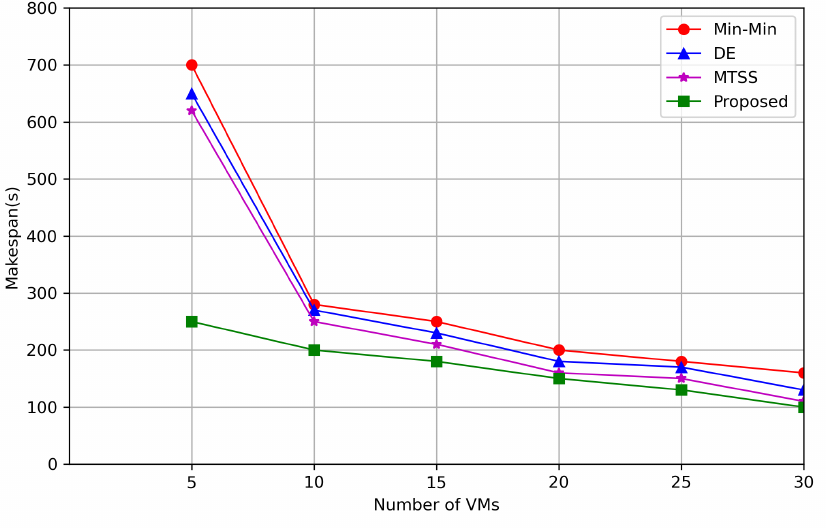
Figure 17. Performance evaluation by using task-completion time with the number of VMs.